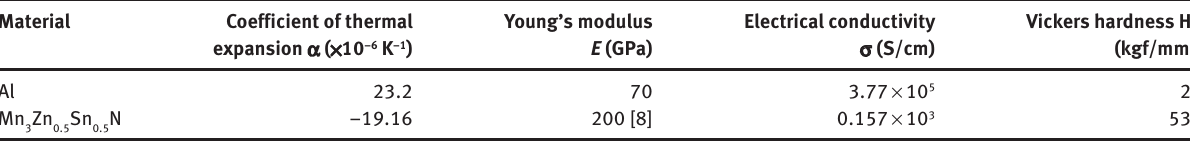
Young’s modulus Electrical conductivity E (GPa)